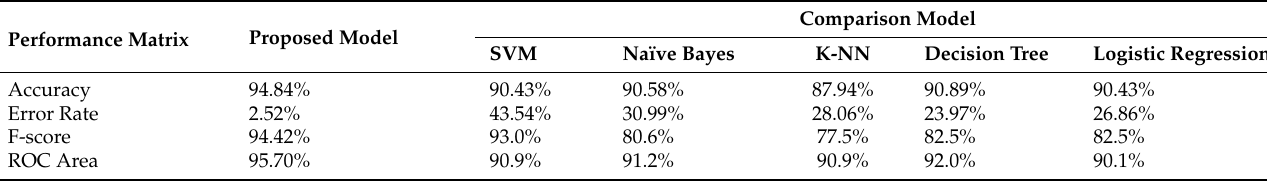
Table 9. Comparative